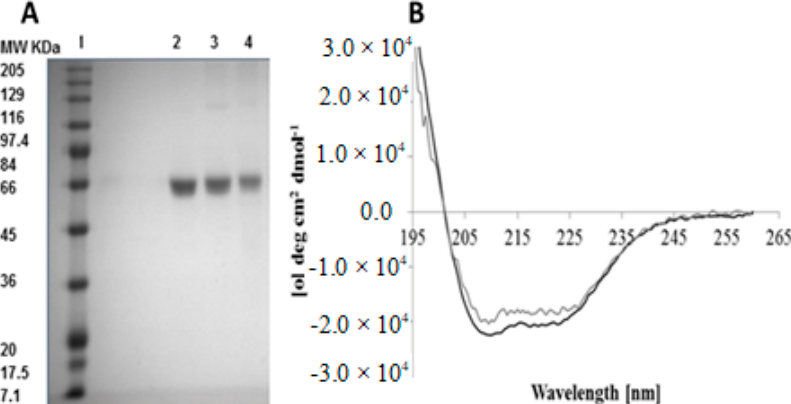
Figure 5. SDS-PAGE to evaluate the BSA stability released from cationic CHL NPs/NCMPs ( A ). Lanes represent, molecular weight (MW) standard markers, BSA (MW 66,000) ( 1 ), BSA standard ( 2 ), BSA released from hybrid cationic CHL NPs ( 3 ), and BSA released from cationic CHL NPs/NCMPs ( 4 ). Difference in band intensity was due to different loading. (The CD spectra of BSA released from cationic CHL NPs/NCMPs (grey) and BSA standard (black) ( B ) ( n = 3).